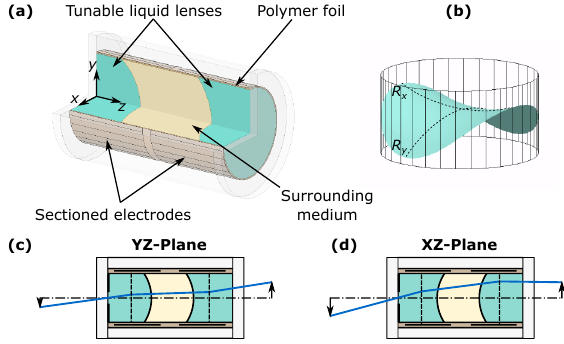
Figure 1. (a) Structure of the device, (b) double-plane symmetric interface simulated using Surface Evolver and (c)(d) simplified ray diagram of the two active planes (not to